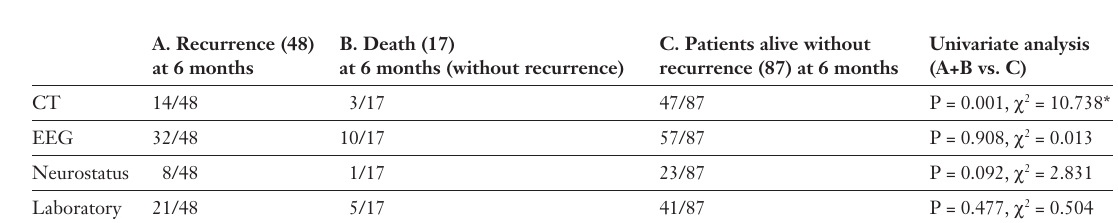
Treatment and fol- low-up at 6 months in relation to chosen treatment at study enrolment.